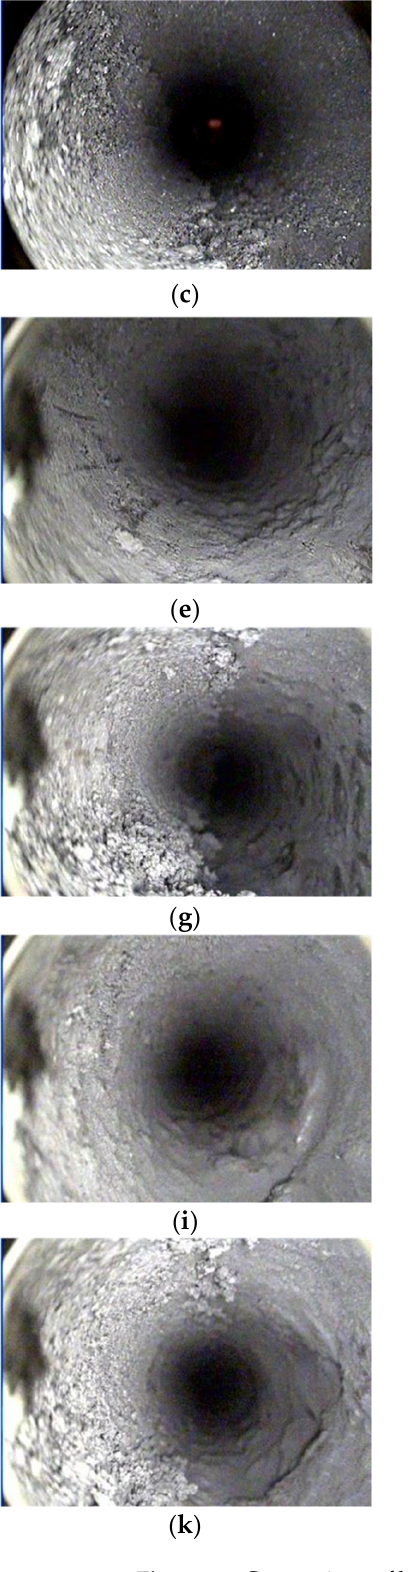
Figure 19. Comparison of borehole observation results before and after crack filling. ( a ) roof 1.0 m; ( b ) roof 1.0 m (filling); ( c ) roof 5.0 m; ( d ) roof 5.0 m (filling); ( e ) left rib 1.0 m; ( f ) left rib 1.0 m (filling); ( g ) left rib 5.0 m; ( h ) left rib 5.0 m (filling); ( i ) right rib 1.0 m; ( j ) right rib 1.0 m (filling); ( k ) right rib 5.0 m; ( l ) right rib 5.0 m (filling).